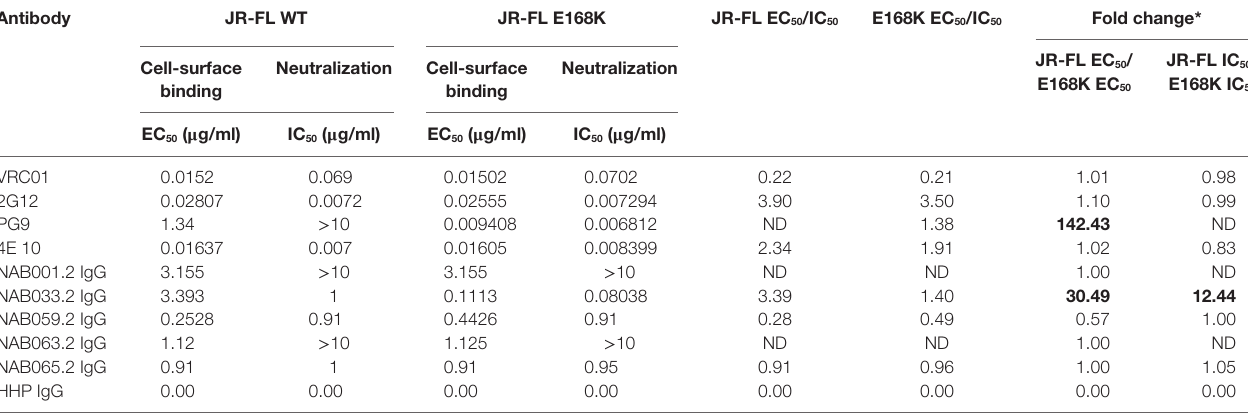
TaBle 7 | Comparison of cell-surface binding (EC 50 ) and neutralization activity (IC 50 ) of IgG eluted from BCN samples against JR-FL WT and JR-FL E168K mutant. antibody Jr-Fl